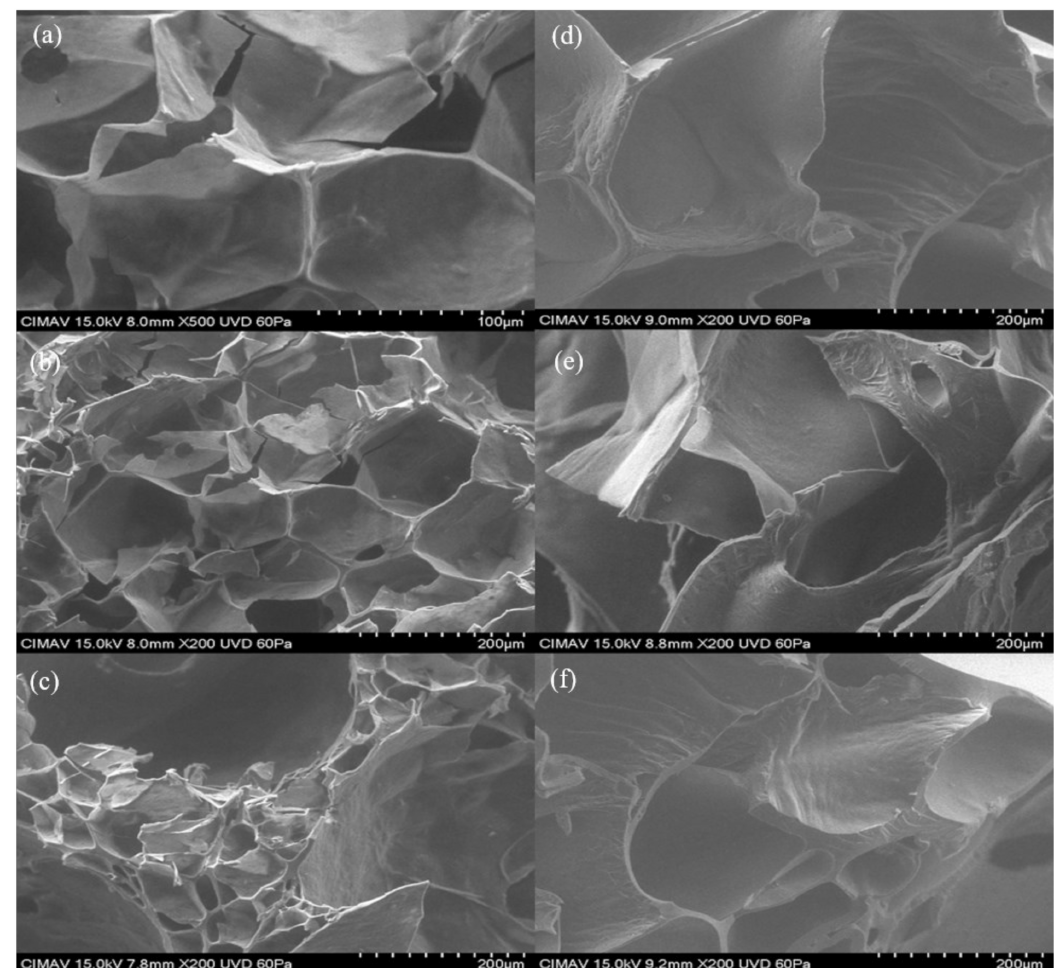
Figure 13. Micrographs of the expanded product. ( a ) Formulation 1 (500 × ), ( b ) Formulation 1 (200 × ), ( c ) Formulation 1 (200 × ), ( d – f ) Formulation 7 (200 ×